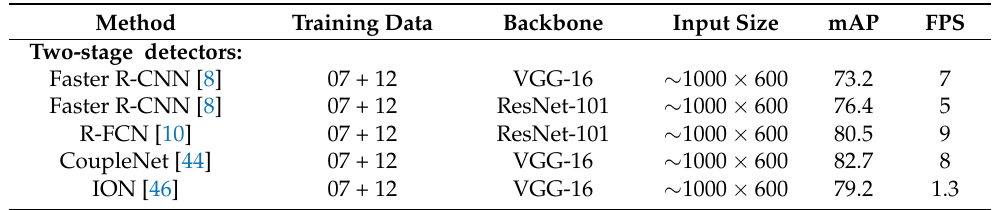
Table 2. Comparison of our method with existing detectors on the PASCAL VOC 2007 test set (with IoU = 0.5); 07 + 12: 07 trainval + 12